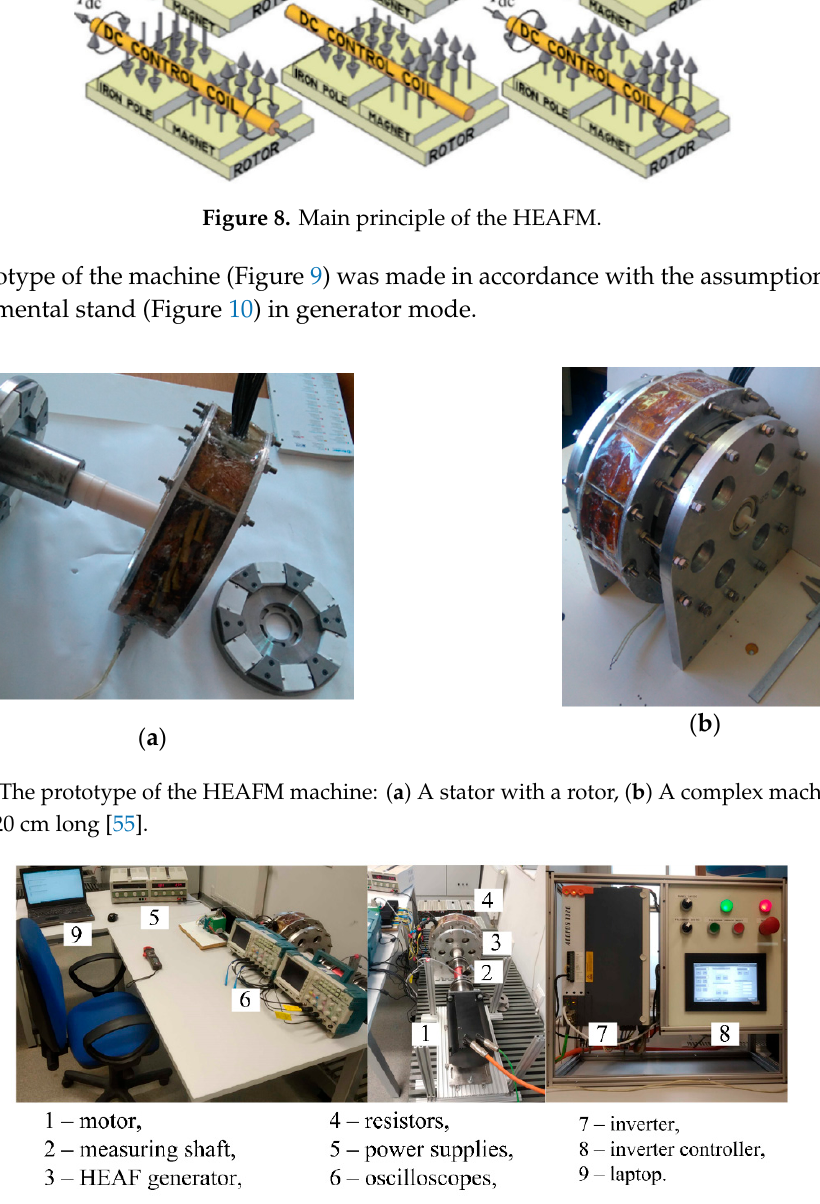
Figure 10. Experimental stand